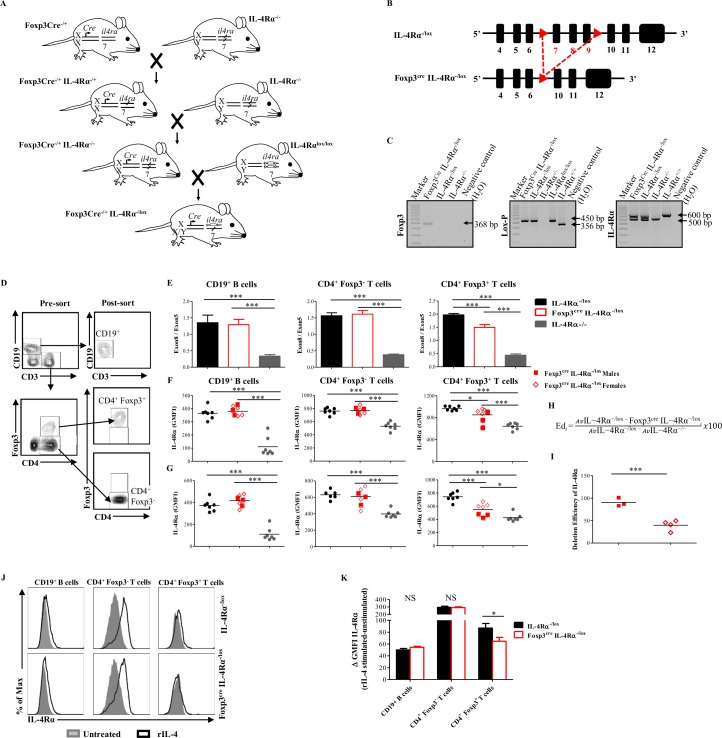
Generation and characterization of Foxp3Cre−/+ IL-4Rα−/lox mice.(A) Mouse breeding strategy. IL-4Rα−/− BALB/c mice were intercrossed for two generations with transgenic BALB/c mice expressing Cre-recombinase under control of foxp3 gene promoter and IL-4Rαlox/lox mice to generate Foxp3Cre−/+ IL-4Rα−/lox BALB/c mice. (B) Schematic diagram showing the structure of il4ra gene loci in IL-4Rα−/lox and Foxp3cre IL-4Rα−/lox mice. (C) Genotyping of Foxp3Cre−/+ IL-4Rα−/lox mice. The Cre specific amplicon is 368 bp, loxP is 450 bp (floxed) or 356 bp (wild type), the wild-type IL4-Rα amplicon is 600 bp, and the deleted IL-4Rα amplicon is 471 bp. (D) Representative flow cytometric analysis of the CD19+, CD4+ Foxp3−, and CD4+ Foxp3+ cell populations before and after FACS sorting of pooled cells from spleen and MLN of naïve IL-4Rα−/lox, Foxp3cre IL-4Rα−/lox, and IL-4Rα−/− mice. (E) Efficiency of IL-4Rα deletion by qPCR. Genomic DNA was extracted from sorted CD19+ B cells, CD4+ Foxp3−, and CD4+ Foxp3+ T cell, and il4ra exon 8 (deleted in IL-4Rα deficient cells) was quantified by qPCR and normalized to the quantity of exon 5 (present in all cells). (F) Flow cytometry analysis of IL-4Rα expression by CD19+ B cells, CD4+ Foxp3−, and CD4+ Foxp3+ T cell from the spleen of naïve mice. (G) Flow cytometry analysis of IL-4Rα expression by CD19+ B cells, CD4+ Foxp3−, and CD4+ Foxp3+ T cell from the MLNs of naïve mice. (H) Formula for calculating the Ed of il4ra gene. (I) Efficiency of IL-4Rα deletion on CD4+ Foxp3+ T cells in the MLNs of naïve male and female Foxp3cre IL-4Rα−/lox mice. (J) Representative histograms of IL-4Rα expression before (gray tinted) and after recombinant IL-4 (black solid line) stimulation. Cells pooled from spleen and MLNs from naïve IL-4Rα−/lox and Foxp3cre IL-4Rα−/lox mice were cultured for 40 hr in 0 or 1 ng/ml of rIL-4. (K) Flow cytometry analysis of IL-4Rα GMFI up-regulation from (J). Results are representative of three independent experiments with 6–8 mice/group. Data are expressed as mean ± S.E.M. NS, P > 0.05; * P < 0.05, ** P < 0.001, *** P < 0.0001 by two-tailed unpaired Student t test and one-way ANOVA with Bonferroni posttest analysis. Underlying data can be found in S1 Data. CD3, cluster of differentiation 3; CD4, cluster of differentiation 4; CD19, cluster of differentiation 19; Cre, cyclic recombinase; Ed, efficiency of deletion; FACS, fluorescence-activated cell sorting; Foxp3, forkhead box P3; GMFI, geometric mean fluorescence intensity; IL-4Rα, interleukin-4 receptor alpha; loxP, locus of X-over P1; MLN, mesenteric lymph node; NS, not significant; qPCR, quantitative real-time PCR; rIL-4, recombinant interleukin-4.